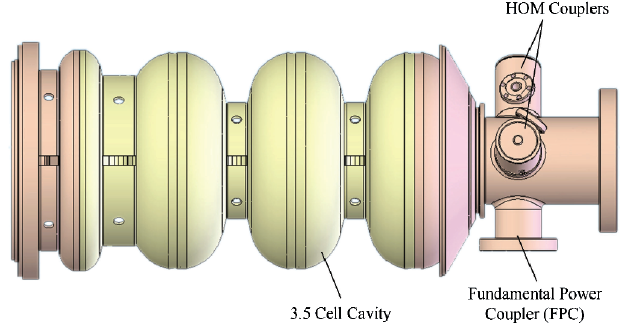
FIG. 11. 1.3 GHz—3.5 cell IHIP SRF gun cavity. Courtesy of Kexin Liu, PKU.